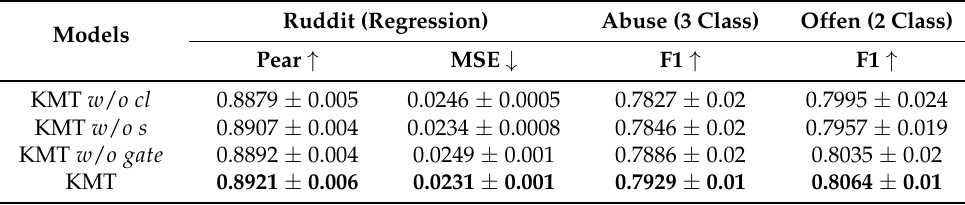
Table 3. Results of ablation experiments. The best results for each model are shown in